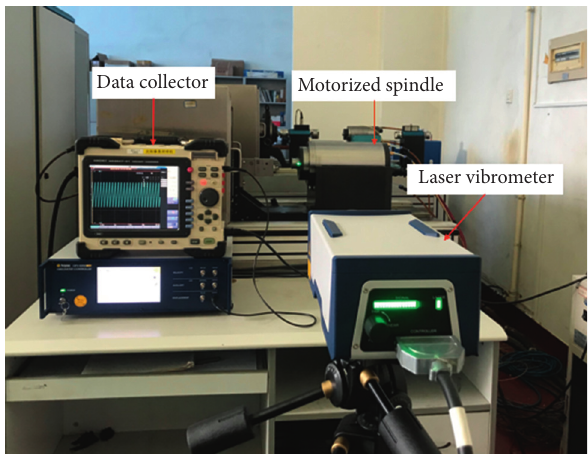
Figure 15: Motorized spindle test platform.